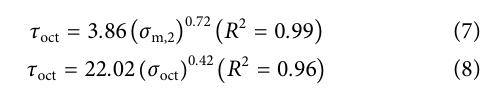
Frontiers in Earth Science |